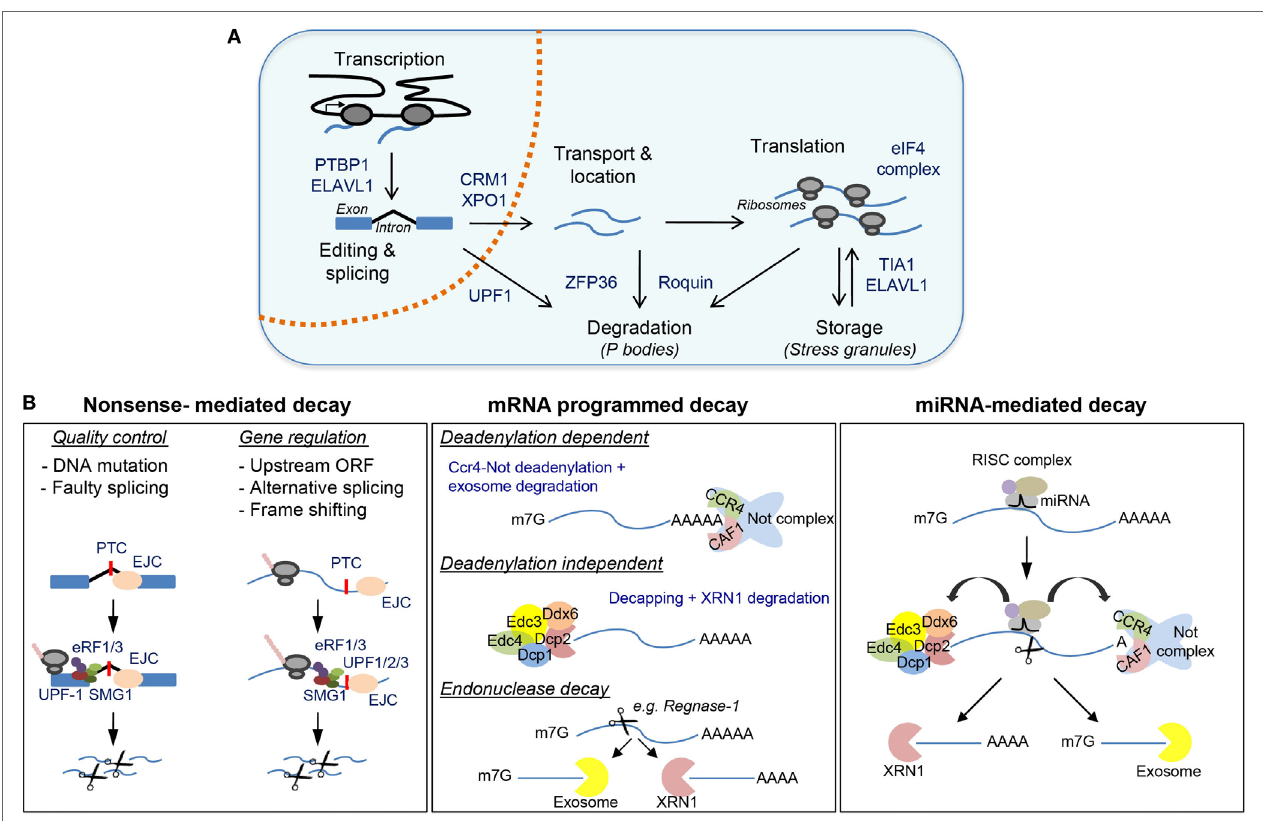
FiGURe 1 | Post-transcriptional regulatory mechanisms controlled by RNA-binding proteins (RBPs) with a detailed view of messenger RNA (mRNA) decay. (A) Major post-transcriptional mechanisms regulated by RBPs include transcription, mRNA editing and splicing, mRNA transport and subcellular localization, mRNA translation, mRNA storage, and mRNA decay. (B) Major mechanisms for mRNA degradation include nonsense-mediated decay (NMD), mRNA programmed decay, and miRNA-mediated mRNA decay. Representative RBPs involved in these mechanisms are shown in (A,B)